Question: In one sentence, what is this figure communicating?
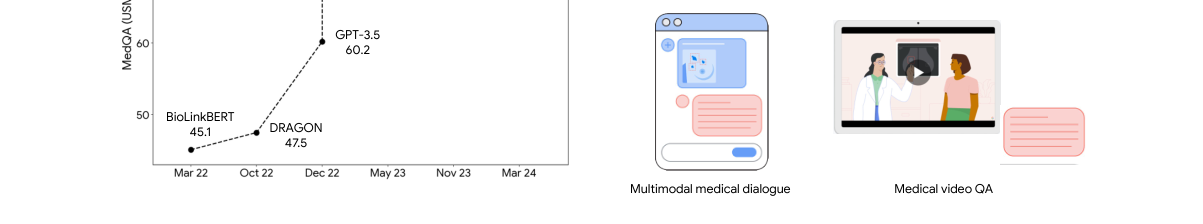
Answer: | Overview of our contributions. We introduce Med-Gemini, a family of highly capable, multimodal medical models built upon Gemini. We enhance our models’ clinical reasoning capabilities through self-training and web search integration, while improving multimodal performance via fine-tuning and customized encoders. Med-Gemini models achieve state-of-the-art (SoTA) performance on 10 out of 14 medical benchmarks that span text, multimodal, and long-context applications, and surpass the GPT-4 model family on every benchmark where a direct comparison could be made. The bar chart shows the relative percentage gains from our models over prior SoTA across the benchmarks. In particular, on the MedQA (USMLE) benchmark, we attain a new SoTA surpassing our prior best (Med-PaLM 2) by a significant margin of 4.6%. Moreover, re-annotation of the dataset with expert clinicians reveals that 7.4% of questions are deemed unfit for evaluation as they either lack key information, have incorrect an